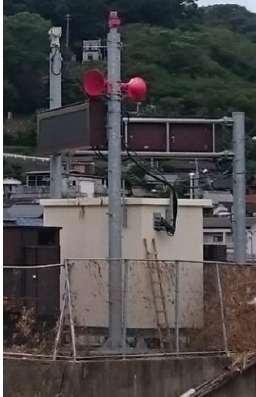
Figure 5. Siren and loudspeaker of the dam operator.